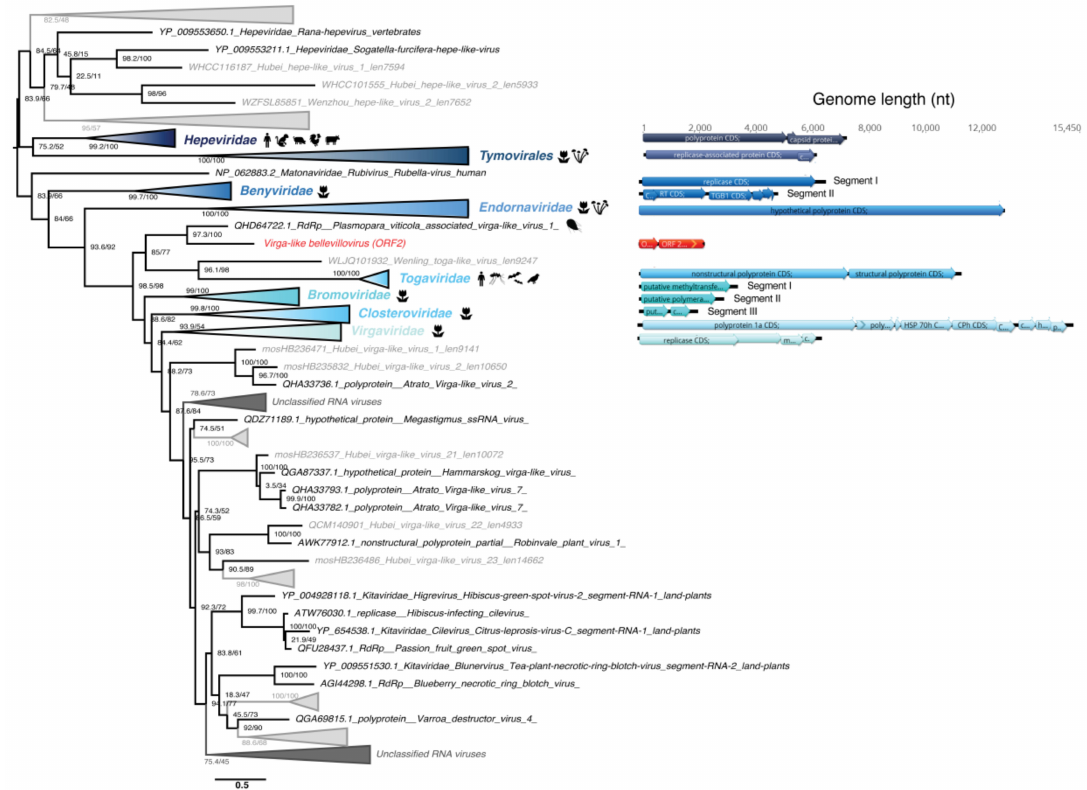
Figure 8. Phylogeny of the Hepe-Virga group RdRp. The hepe-virga-like sequence identified in this study is labeled in red. Unclassified sequences from [65] are highlighted in grey. For clarity, some families or genera have been collapsed. Left, RdRp-based phylogenetic tree obtained using IQ-tree with bootstrap replicates and SH-aLTR set to 1000 (values in parenthesis). Right, genomic organizations of the new viruses as well as closest homologs and representative species from each family / genus as follows: Orthohepevirus A ( Hepeviridae ); Poinsettia mosaic virus (order Tymovirales ); Wheat stripe mosaic virus ( Benyviridae ); Diatom colony associated dsRNA virus 15 ( Endornaviridae ); Cabassou virus ( Togaviridae ); Apple mosaic virus ( Bromoviridae ); Mint virus 1 ( Closteroviridae ); Cucumber mottle virus ( Virgaviridae ). The tree is mid-pointed rooted and branch lengths are scaled according to the number of amino acid substitutions per